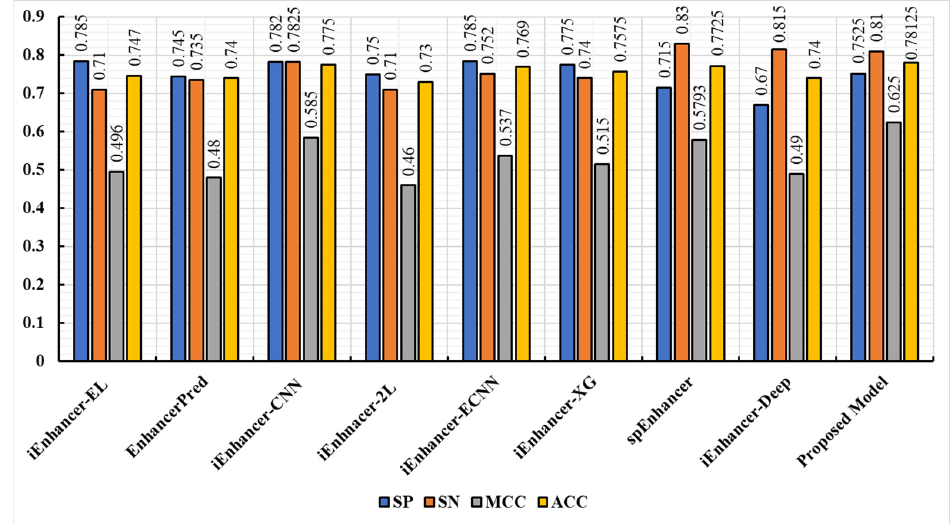
Figure 7. The performance of state-of-the-art predictors and the proposed model in the independent test in the first stage.